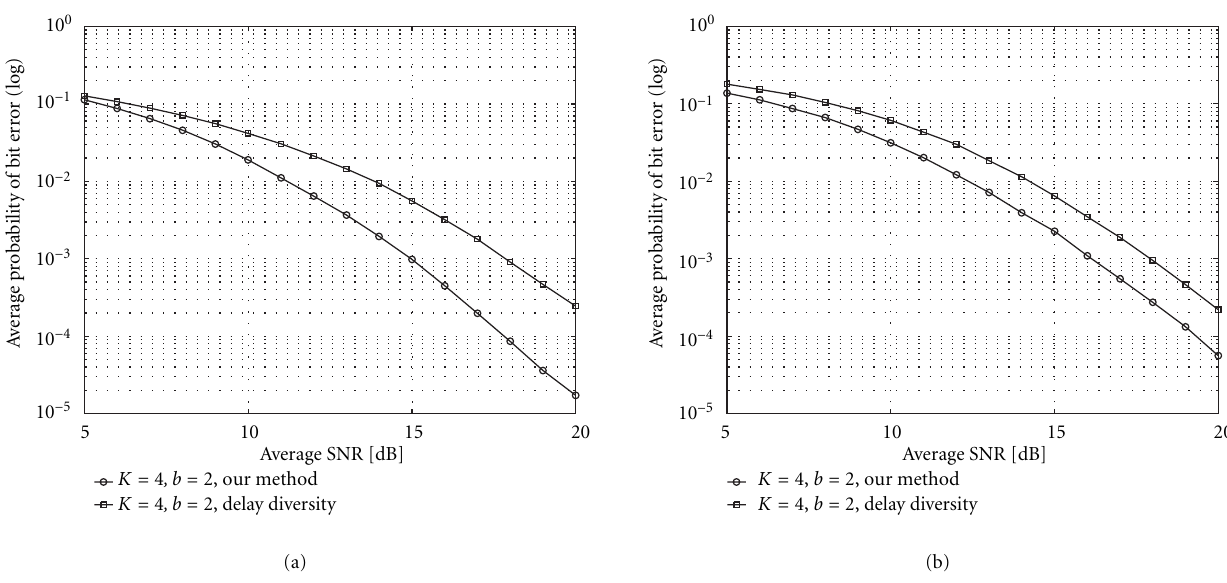
Figure 7: Simulation results III. (a) Four transmit antennas with asymmetric QPSK, (b) four transmit antennas with 4ASK.